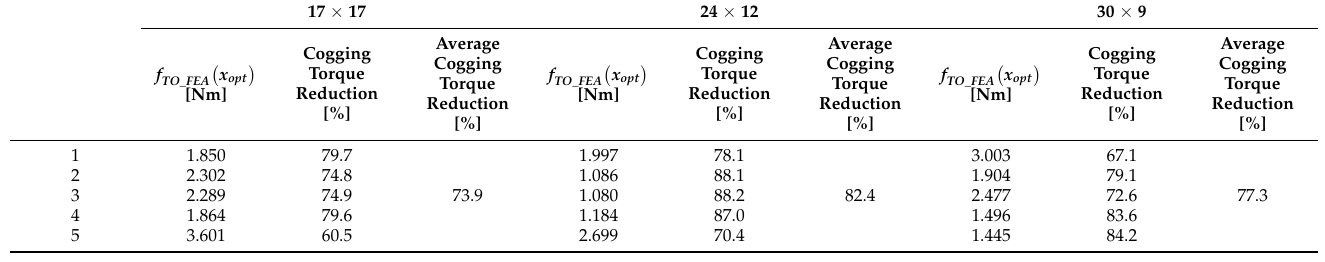
Table 7. Results obtained with the direct approach on the APMM with 20 stator segments. 17 × 17 24 × 12